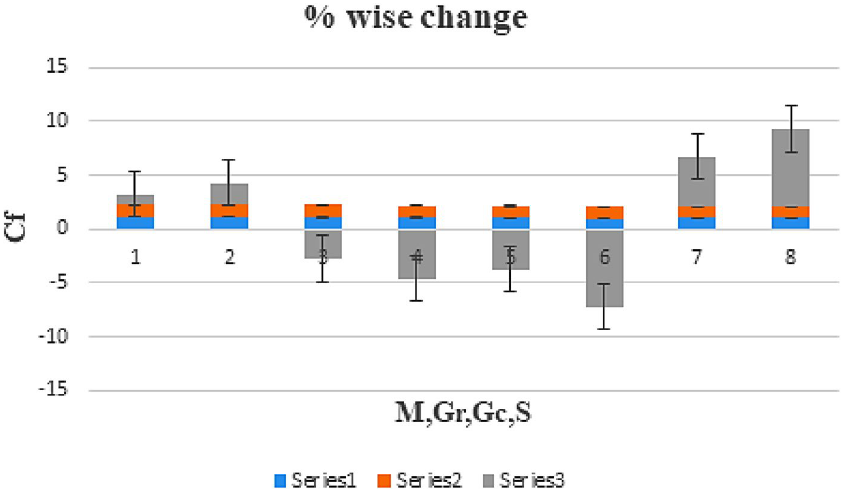
Figure 16. % Wise change in the skin friction coefficient due to the variation In parameters M , Gr , Gc . When Pr = 6.2, Ec = 1, Nt = Nb = Sc = 0.3 .